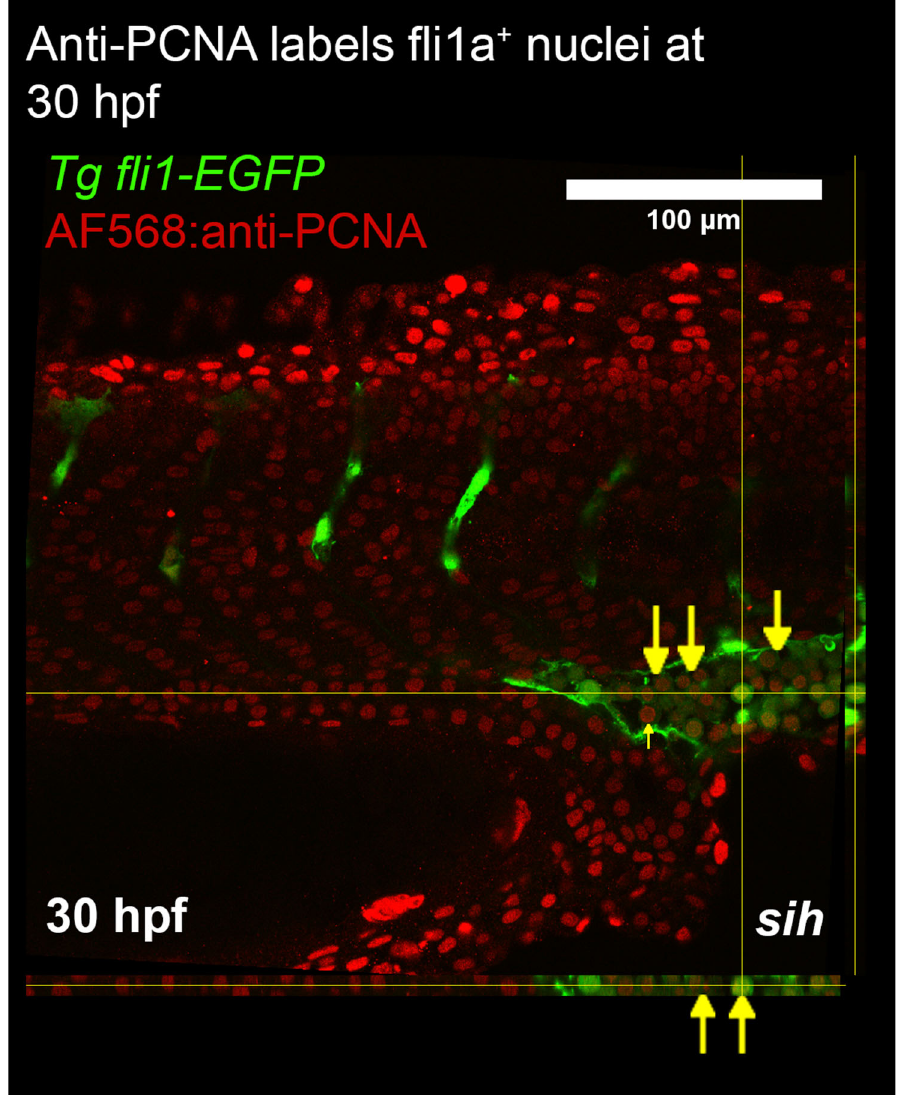
caudal vein plexus and intersegmental vessels were imaged to determine whether endothelial cell proliferation was detected in these vascular beds. At 30 hpf anti-PCNA was colocalised with fli1a positive cells (labelled with yellow arrows).SinceflowmodifiesECproliferation,westudiedembryoslackingbloodflow(tnnt2amorphants;shown)and controls with normal blood flow. PCNA staining did not detect proliferating endothelial cells in either group. The pattern of staining suggests a deficiency of penetration of anti-PCNA antibodies into the centre of the